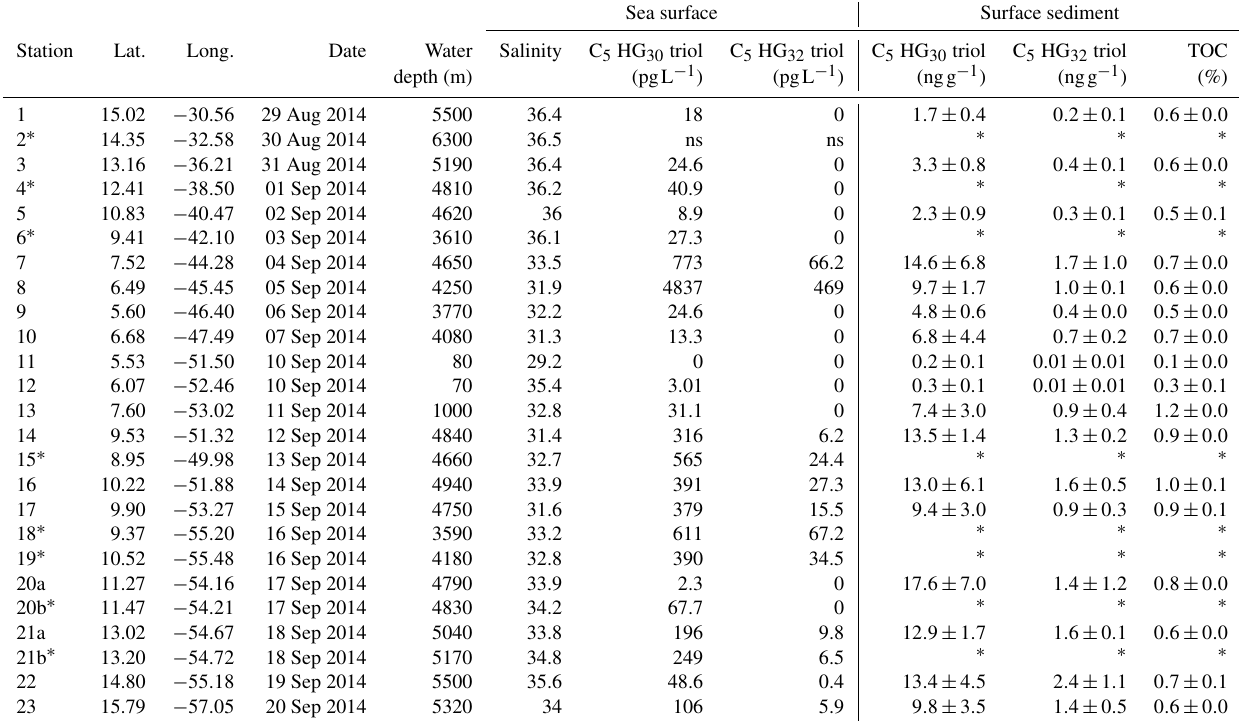
Sea surface Surface sediment